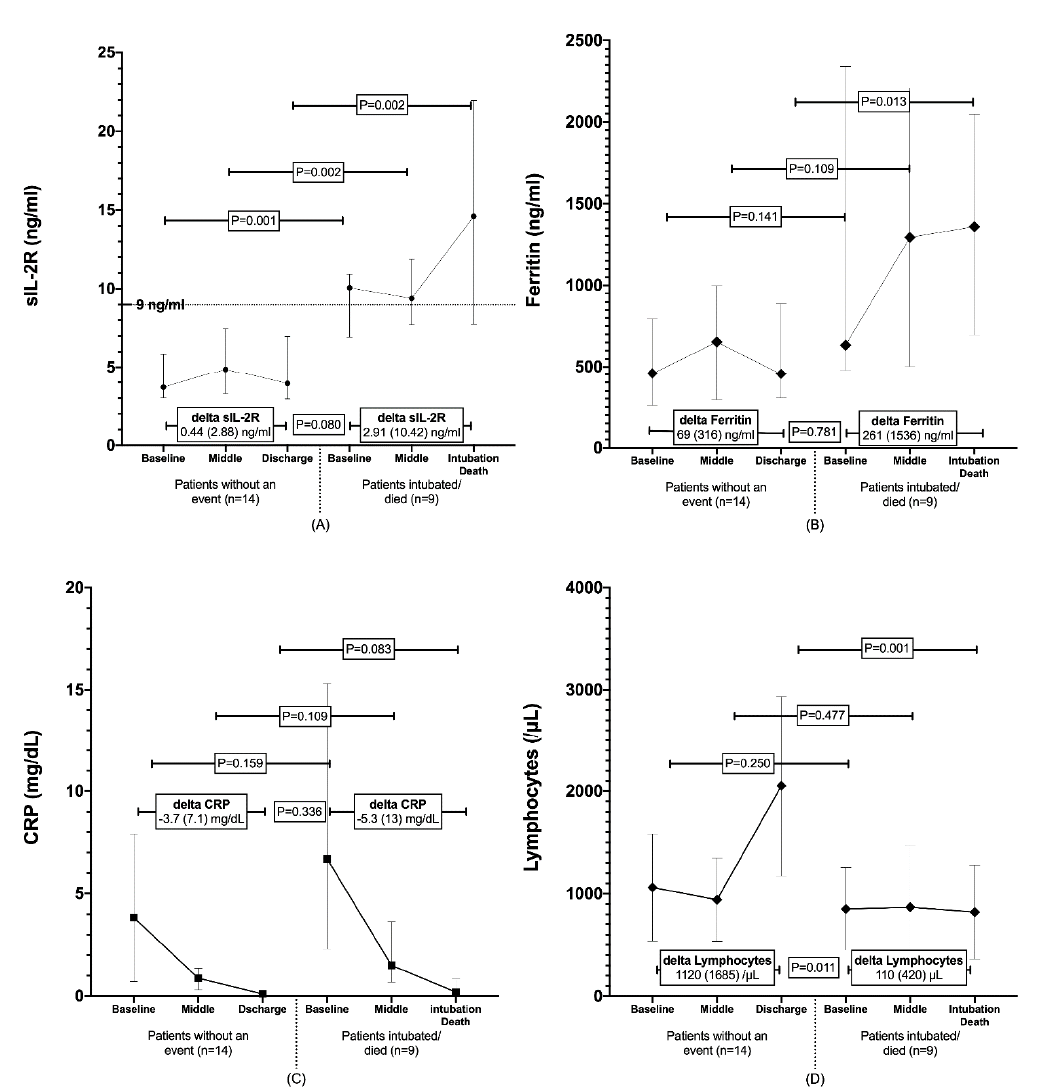
A comparison of median (IQR) sIL-2R at three different time points between patients who were intubated or died ( n = 9) and patients who were discharged from the hospital without intubation ( n = 14) showed higher levels for the former group at three different time points: baseline (10.1 (4) vs. 3.7 (2.8) ng/mL; p = 0.001), middle of hospitalisation (9.4 (4.2) vs. 4.9 (4.2) ng/mL; p = 0.002), time of discharge or intubation/death (14.6 (14.2) vs. 3.9 (4) ng/mL; p = 0.002) (Figure 2A). Furthermore, patients who were intubated or died had higher ferritin levels (1360 (1352) vs. 455 (583) ng/mL; p = 0.013) (Figure 2B) and lower lymphocytes levels (590 (840) vs. 1925 (1500) / µ L; p = 0.001) (Figure 2D) only at the time of intubation/death, compared with patients who were eventually discharged, while no difference was found at middle of hospitalisation (ferritin: 1294 (1707) vs. 653 (704) ng/mL; p = 0.109 and lymphocytes: 700 (1040) vs. 845 (670); p = 0.477) and baseline between the two groups of the patients (ferritin: 634 (1862) vs. 458 (533); p = 0.141 and lymphocytes: 900 (525) vs. 1075 (833); p = 0.250) (Figure 2B,D). No differences were also identified between the two groups, regarding CRP levels at three time points (baseline: 6.7 (13) vs. 3.8 (7.2); p = 0.159, middle of hospitalisation: 1.5 (2.9) vs. 0.9 (1.1), p = 0.109, time of intubation/death or discharge: 0.2 (0.7) vs. 0.1 (0.2); p = 0.083) (Figure 2C).